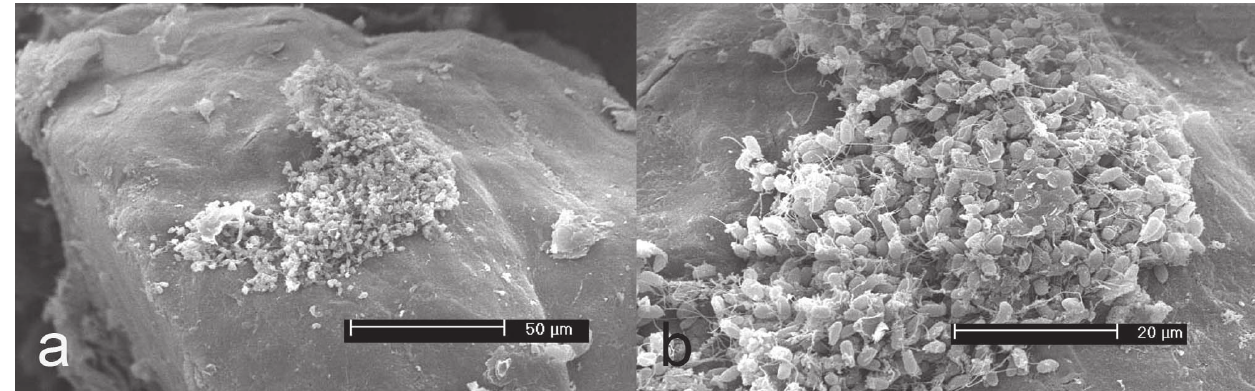
Fig. 2. Scanning Electron Micrography of an oocyte of Compsura heterura from an ovary critical-point dried and crushed with a needle on a stub, showing the spermatozoa observed over an oocyte ( a ), and an amplified image of these spermatozoa ( b